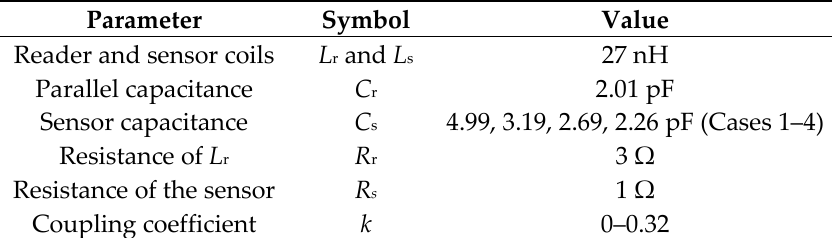
Figure 1. ( a ) The lumped element model used in the simulations ( b ) The resonance coil was co-axially placed away from the reader coil and the distance was set by using plastic washers. ( c ) The resonance frequency estimates ( f max or f p ) and the corresponding height or depth were estimated from the impedance data. Table 1. The parameter values used in the